Question: What kind of plot is shown here?
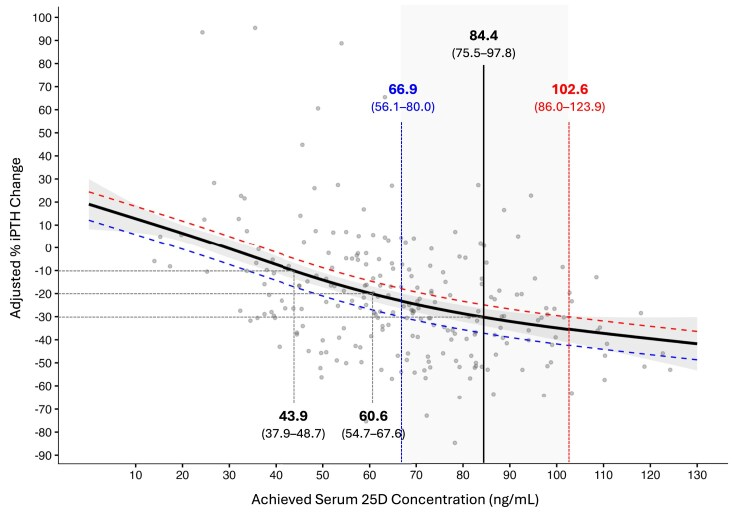
Answer: line